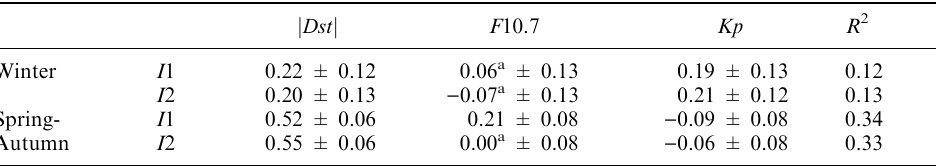
Table 4. Seasonal variations of partial correlation